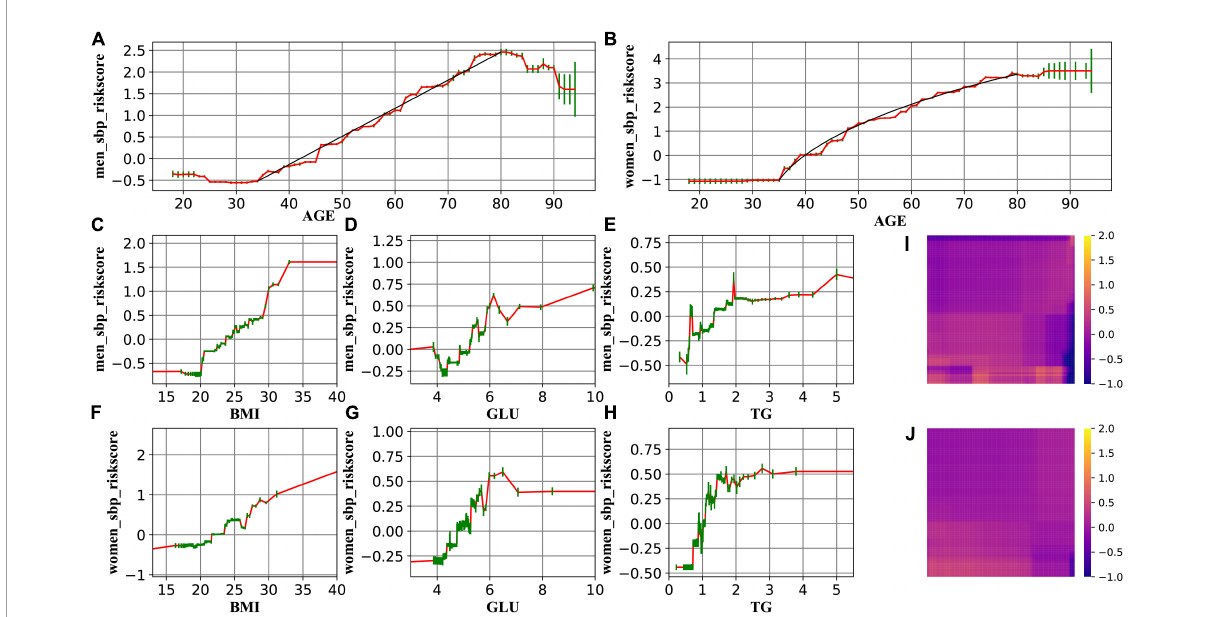
FIGURE2 The change in the risk of high SBP related to age ( A for men and B for women), BMI ( C for men and F for women), GLU ( D for men and G for women), and TG ( E for men and H for women). (I,J) Demonstrate that the interaction effect is marginal. Red lines represent the spline-based GAM curves. Green lines represent the confidence intervals. Black lines in A and B are drawn to guide the eyes.